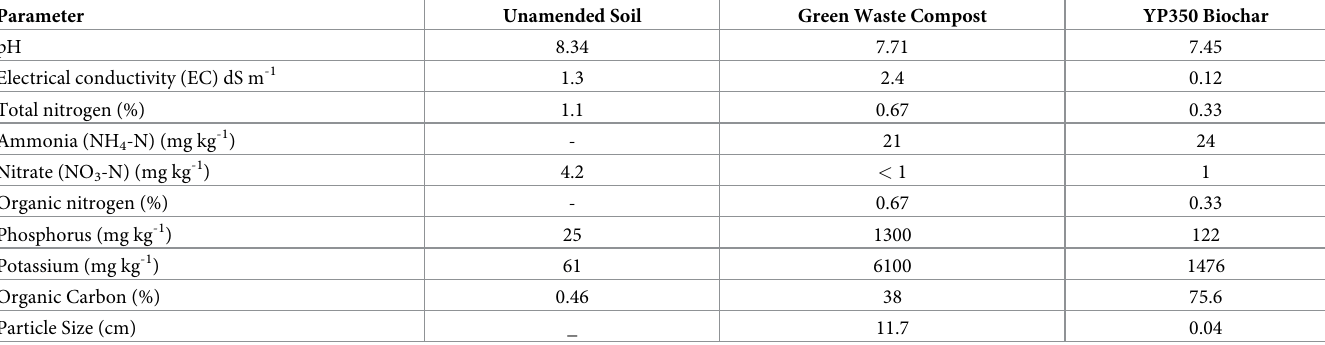
Table 1. Basic characteristic of unamended soil, green waste compost and biochar (0–15